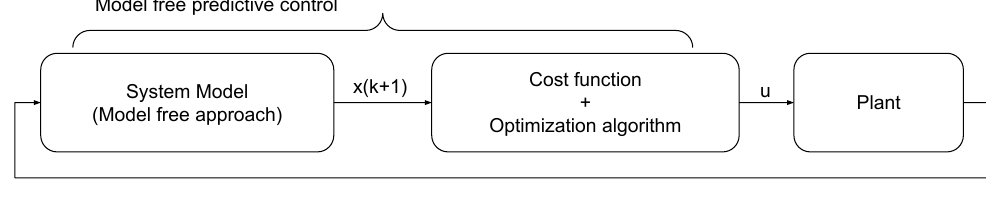
Figure 9. Model-free predictive control